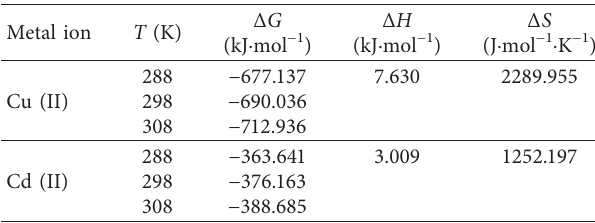
Table 5: Thermodynamic parameters of SACL adsorption